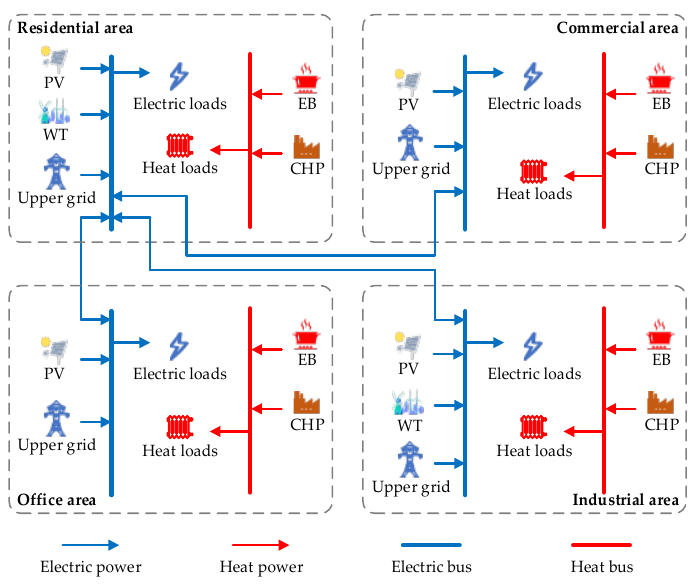
Figure 4. Structure of integrated electricity and heating system with multiple functional areas.